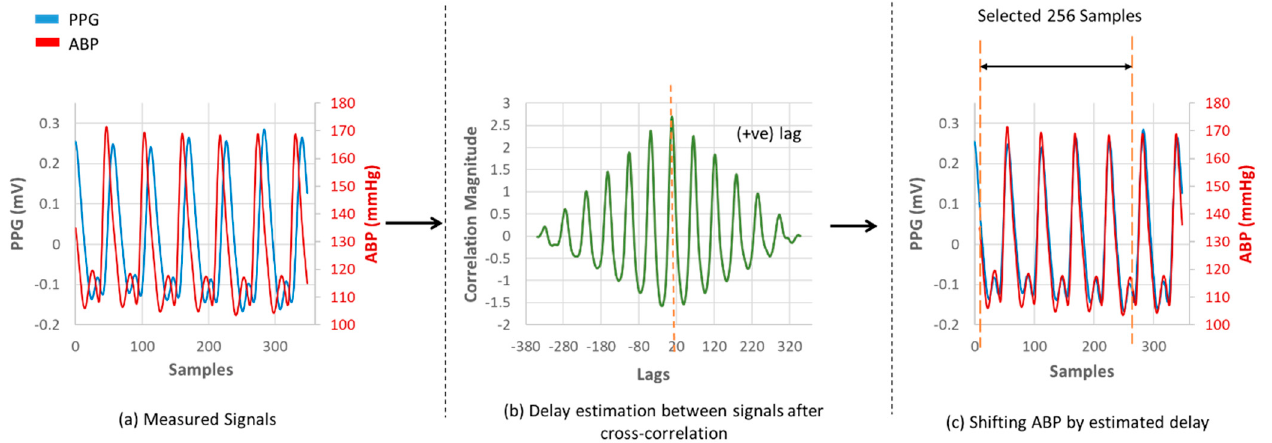
Figure 6. Phase matching between PPG and ABP signals. ( a ) Measured Signals; ( b ) Delay estimation between signals after cross-correlation; ( c ) Shifting ABP by estimated delay.